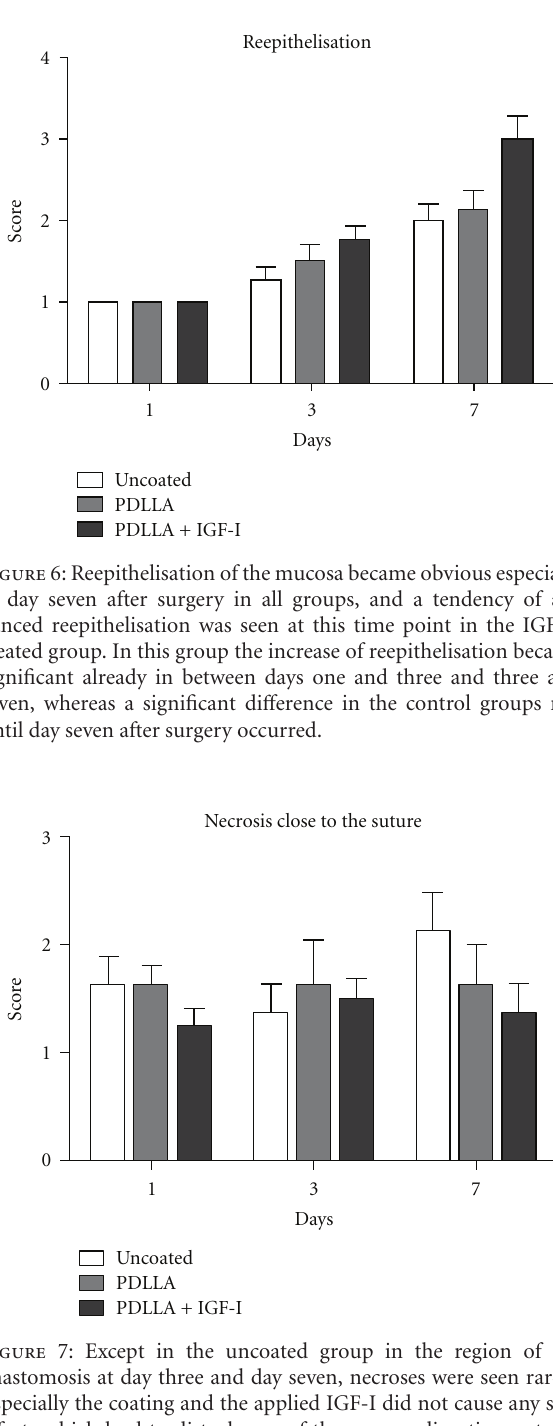
Figure 5: Collagen synthesis increased over the period of time and therefore the amount of cellular connective tissue. Looking at the connective tissue bridging of the anastomosed region over the time, an increased level of connective tissue in the IGF-I-treated group became obvious, even though there was no significant di ff erence measurable at day one and three but at day 7. This e ff ect due to locally applied IGF-I might explain the increased mechanical stability at day three after surgery, since the increase of connective tissue was significantly higher in the growth factor treated group in between day one and three, but was not significant in the control groups.